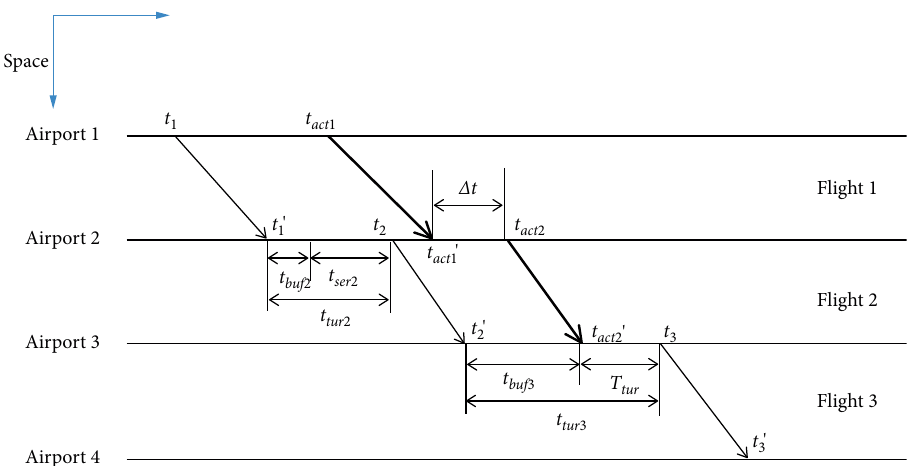
Figure 5: Time–space graph of one aircraft’s route.